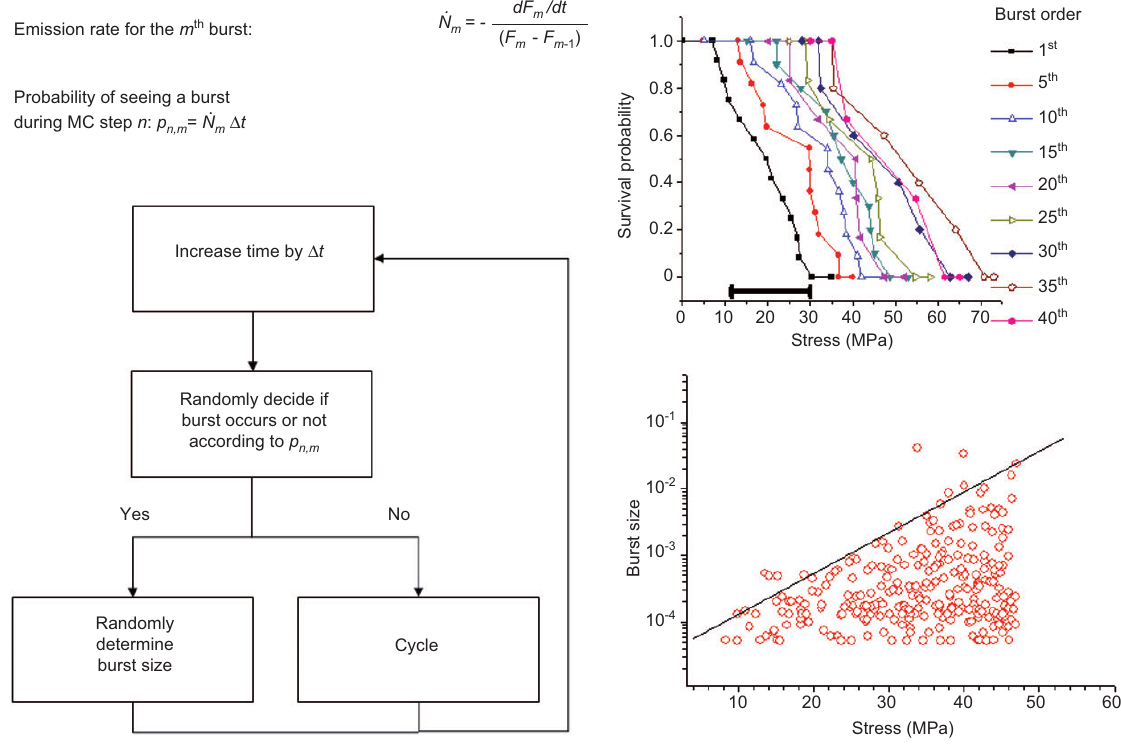
Figure 8 A Monte Carlo scheme of implementing the framework in Figure 7 [28]